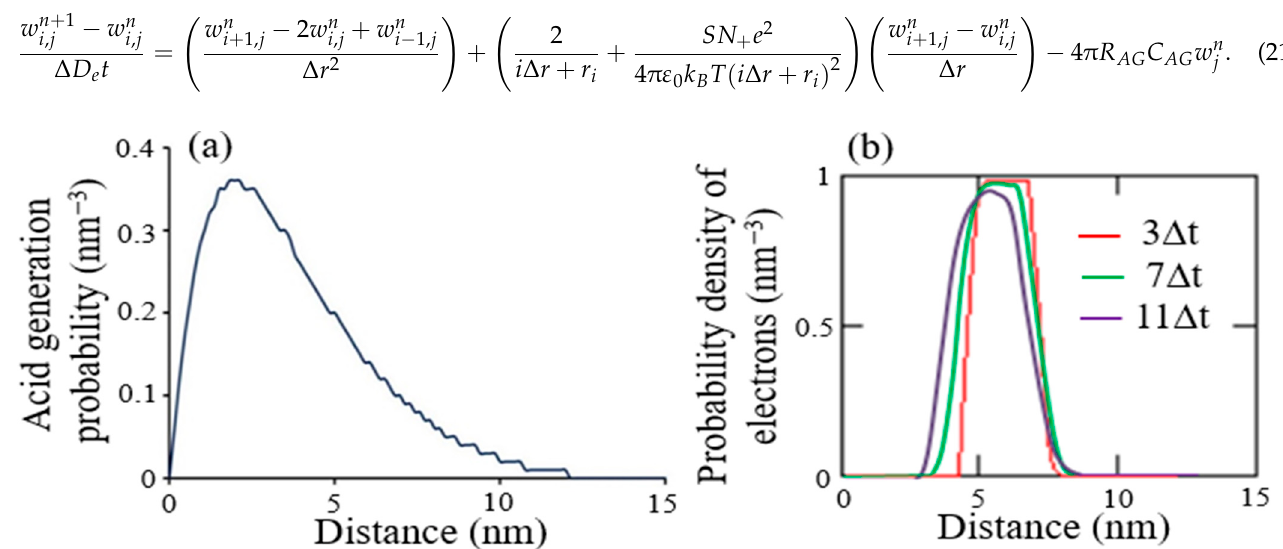
Figure 4. Simulation results: ( a ) probability of acid generation for CAR by Monte Carlo method; ( b ) migration of electron probability density after thermalization in Equation (7). ∆𝑡 is an arbitrary time interval.